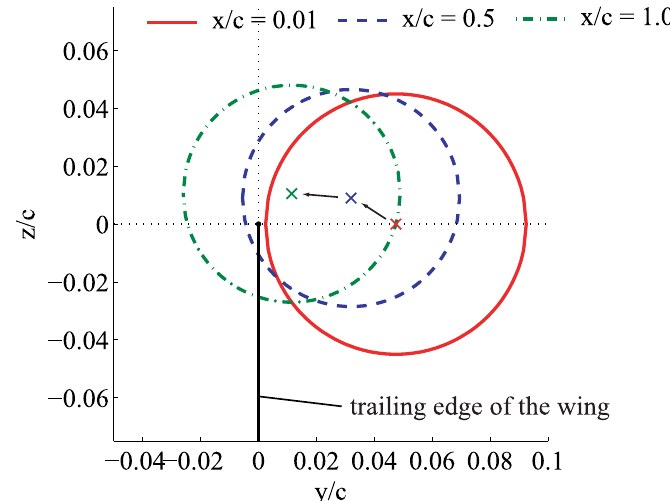
Fig. 4 Positions of the vortex center and its radius.